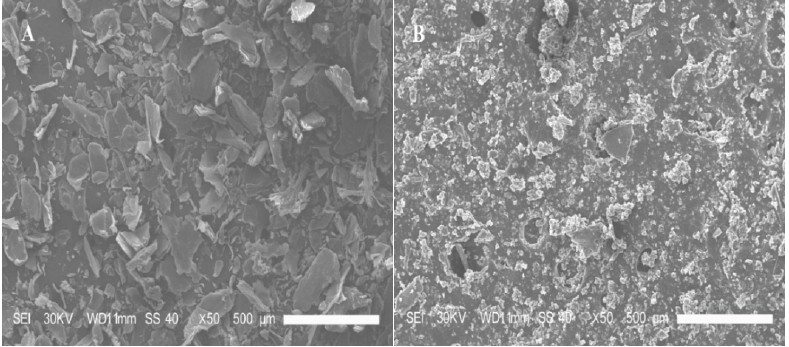
Figure 6. SEM images of the initial chitosan ( A ) and LMWC ( B ) samples, ×50.